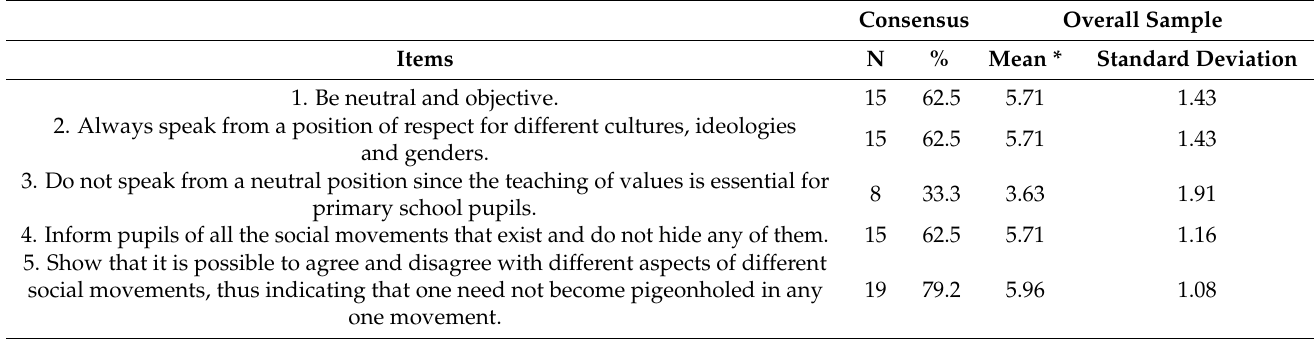
Table 3. Category C. Ethical implications for primary schoolteachers when discussing social move-